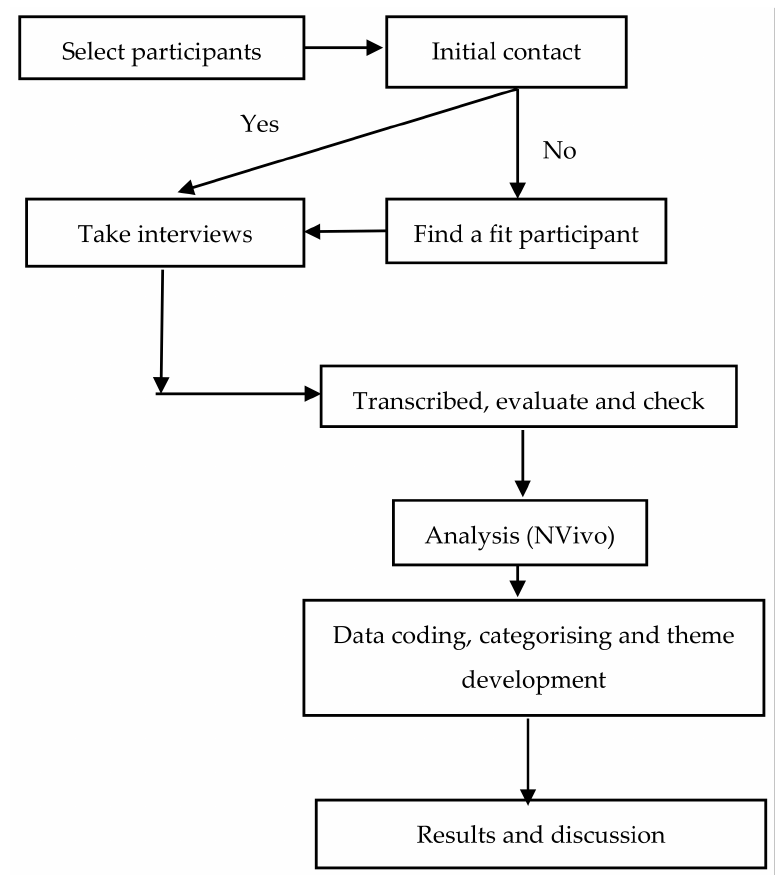
Figure 4. Data collection and analysis